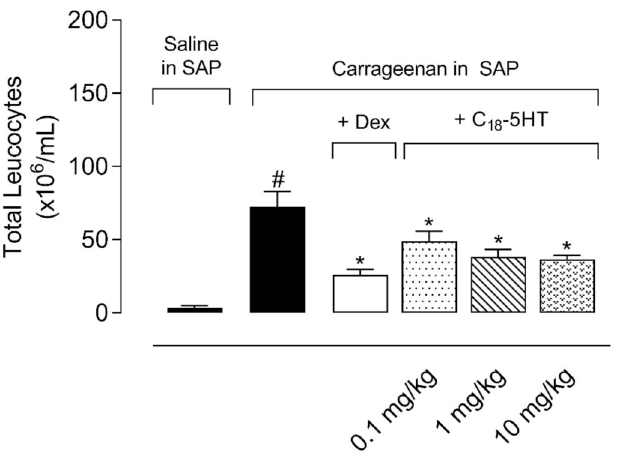
Figure 3. C 18 -5HT reduced cell migration induced by carrageenan into the subcutaneous air pouch (SAP). The animals were pretreated with vehicle (tween 80, p.o.), C 18 -5HT (0.1, 1, or 10 mg/kg, p.o.), or dexamethasone (Dex, 2.5 mg/kg, i.p.) 60 min before carrageenan (1%, w / v ) injection into SAP. Results are expressed as mean ± S.D. (n = 6–8). The statistical significance was calculated by ANOVA followed Newman’s post-test. # p < 0.05 when comparing the vehicle-treated group that received carrageenan in SAP with the vehicle-treated group that received saline in SAP and * p < 0.05 when comparing the dexamethasone or C 18 -5HT pretreated groups that received carrageenan in SAP with the vehicle-treated group that received carrageenan in